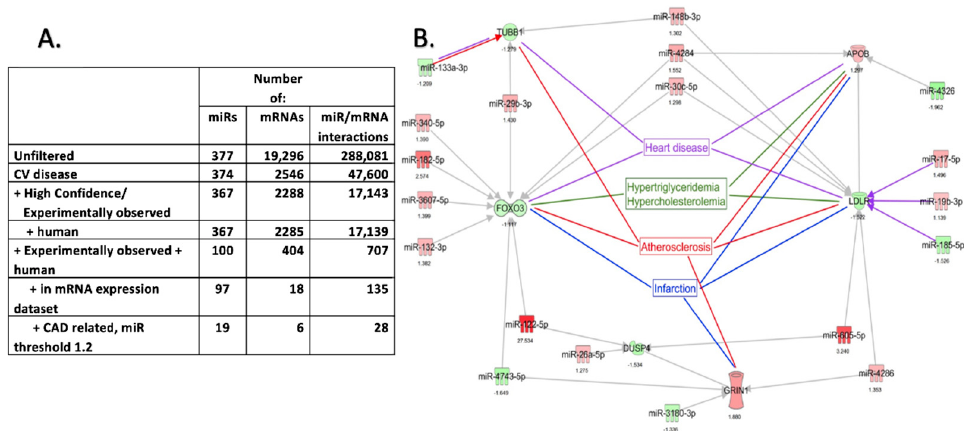
Figure 6. Pathway enrichment analysis of the DEmiRNAs and DEmRNA interactions from EAT and SAT: Ingenuity Pathway Analysis (IPA) was used to perform pathway enrichment analysis on the mRNA (RNA-seq) and miRNA (microRNA microarray) that were differentially expressed in EAT compared to SAT. Targets of miRNAs relevant to cardiovascular diseases were identified after a stringent filtering process ( A ). mRNA targets of DEmiRNAs are shown with IPA annotations for selected cardiovascular disorders ( B ). Six miRNA–mRNA pairs that played a role in cardiovascular disease were identified.